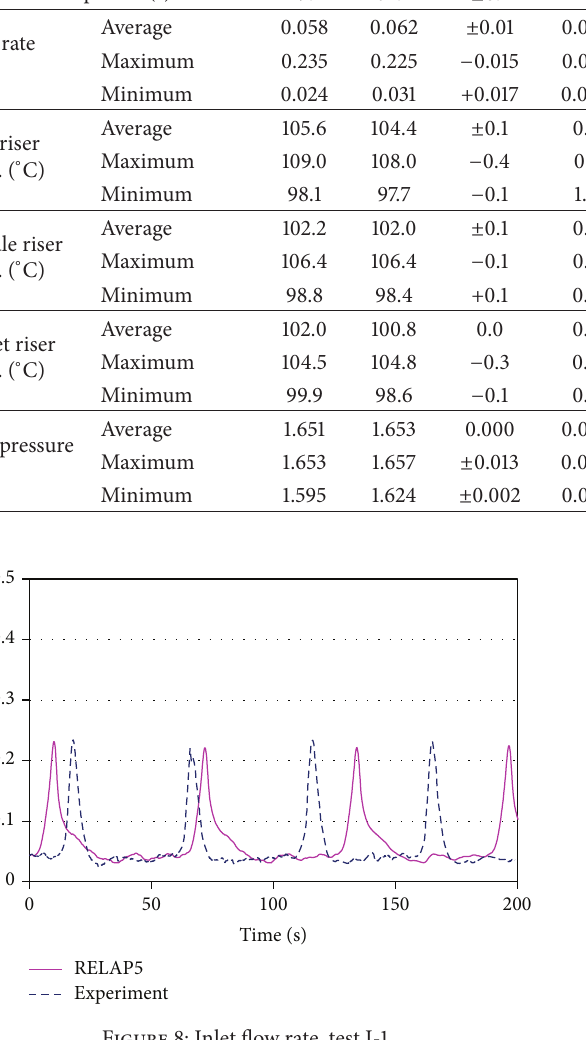
Figure 8: Inlet flow rate, test I-1.